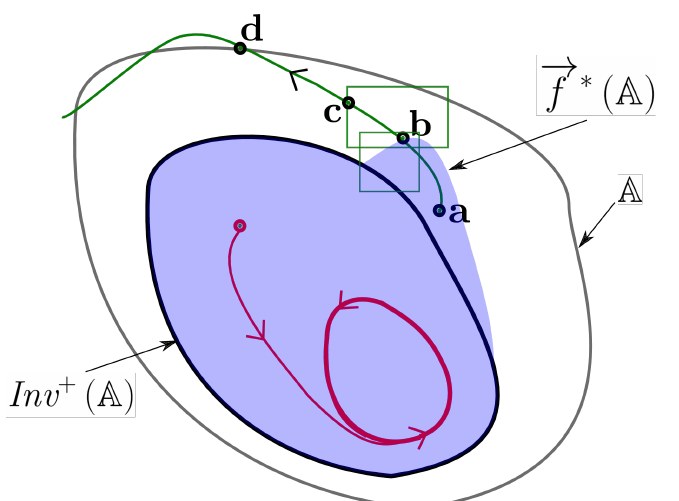
Figure 6. An inconsistent situation that can never occur where a ∈ Inv + ( A ) but a / ∈